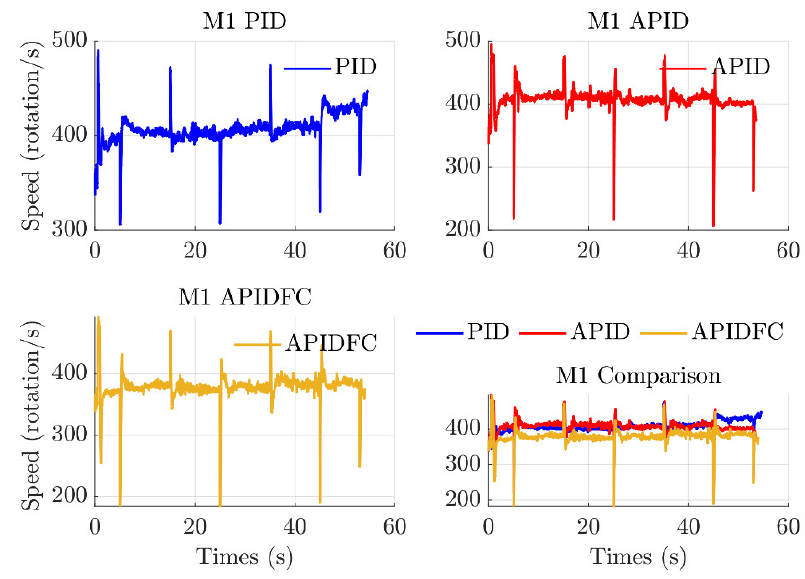
Figure 19. Motor M1 rotation speed comparison between controllers.